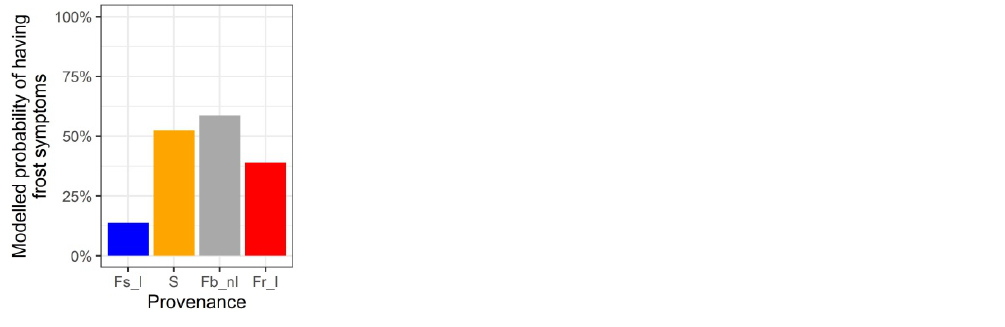
Figure 12. Modelled frost damage in 2019. Only the provenances that differ significantly from the standard provenance Sonian are shown. Abbreviations of provenances are in Table 1.